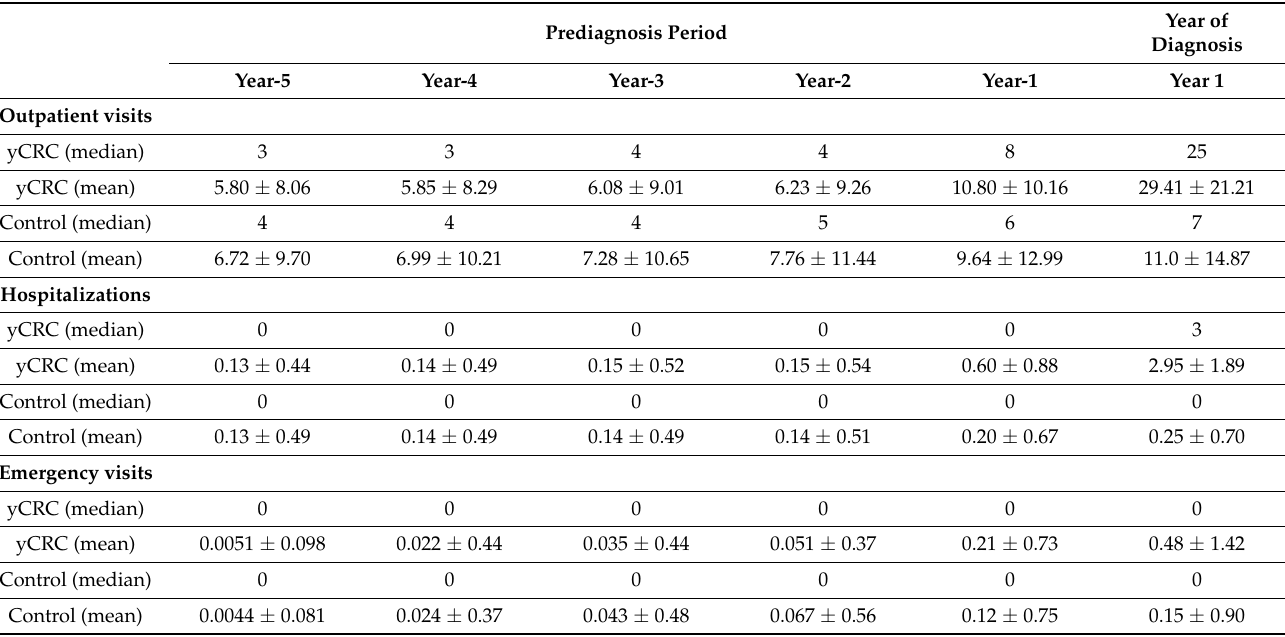
Table 2. Healthcare utilization among yCRC cases and cancer-free controls during prediagnosis period (years-5 to -1) and year of diagnosis (year 1).